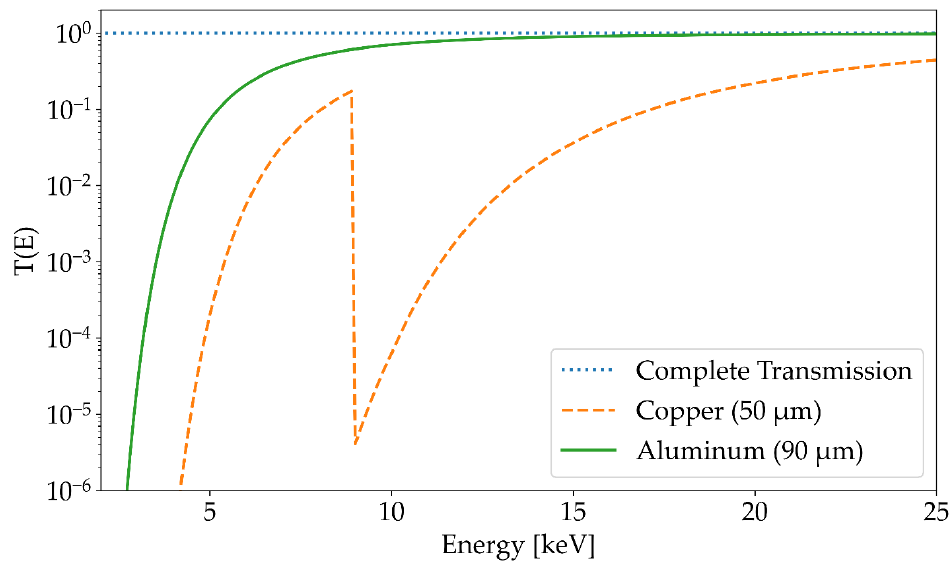
Figure 7. Transmission function T ( E , d ) (see Equation (1)) for 50 µm of copper (orange dotted curve) and 90 µm of aluminum (solid green curve) as a function of the energy. For the calculation, the list of mass attenuation coefficients from the National Institute of Standards and Technology was used. The values were logarithmically interpolated to get a value for each energy channel of the X-123 spectrometer. The rapid decrease at approximately 9 keV is caused by the sudden increase in the attenuation coefficient of copper due to the Cu-K edge.